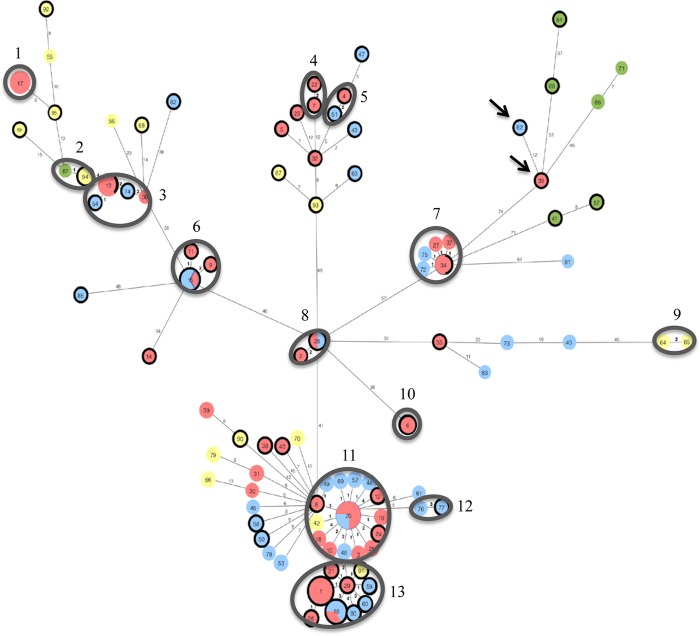
Minimum spanning phylogenetic tree of the core genome of 113 sequenced Salmonella Heidelberg isolates with reference S. Heidelberg 12-4374, generated using Phyloviz. Colors for sources of isolates are as follows: red, human; yellow, abattoir chicken; blue, retail chicken; green, retail turkey. Isolates outlined in dark black are resistant to cefoxitin. Isolates in the same circle have 0 hqSNVs, and the size of each circle is proportionate to the number of isolates in the circle. Numbers on branches between 2 isolates represent the number of hqSNV differences. Clusters of isolates outlined in gray indicate those having 0 to 4 hqSNVs and are labeled 1 to 13. The 2 isolates with arrows indicate strains with a portion of a blaCMY-2 plasmid integrated into the chromosome.